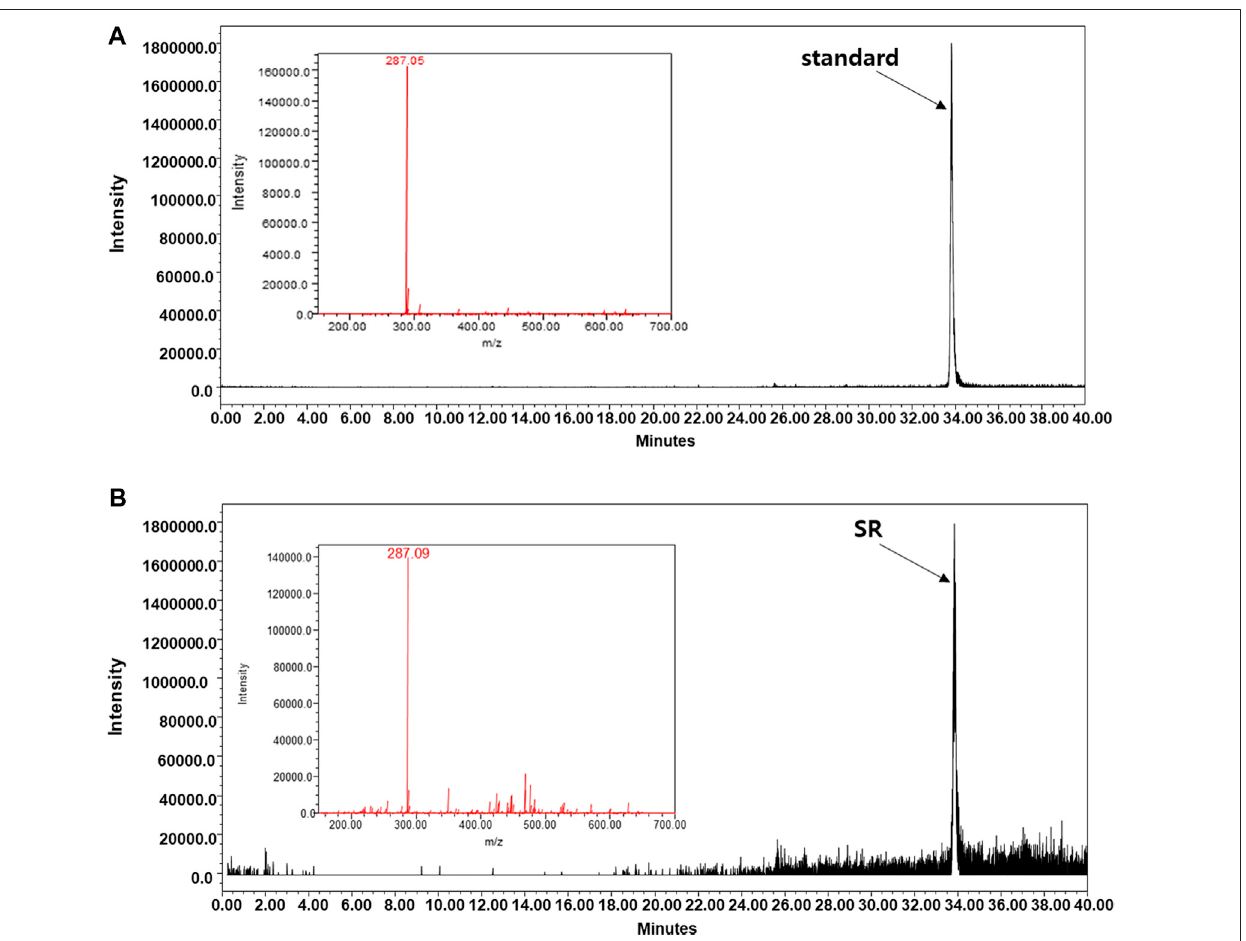
FIGURE 11 | LC-MS analysis was carried out using the A Waters e2695 system. Kaempferol was con fi rmed in the (A) standard and (B) SR extracts.